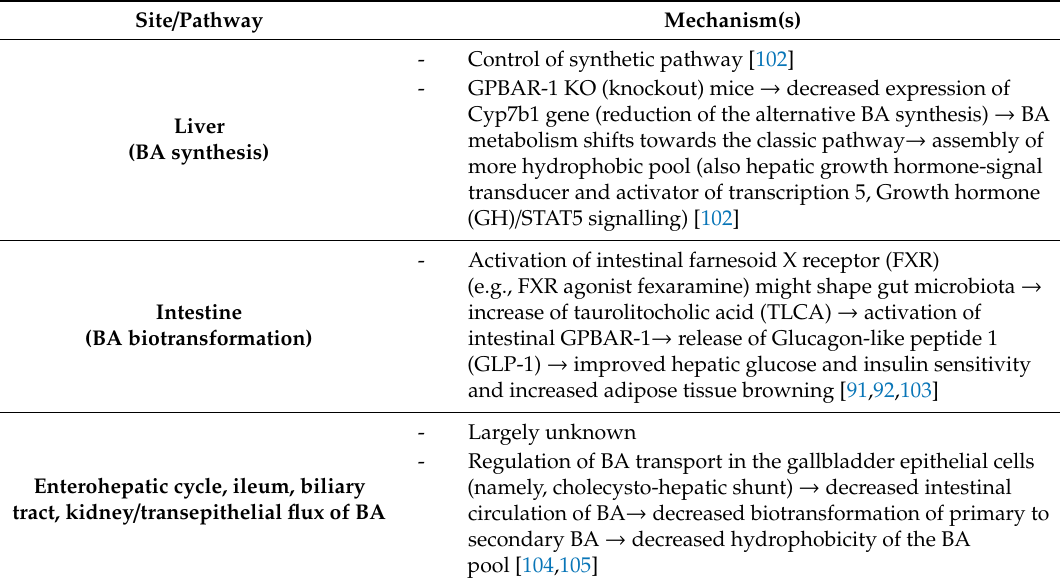
Table 2. Potential mechanisms linking G protein-coupled bile acid receptor 1 (GPBAR-1) to bile acid (BA) pool composition